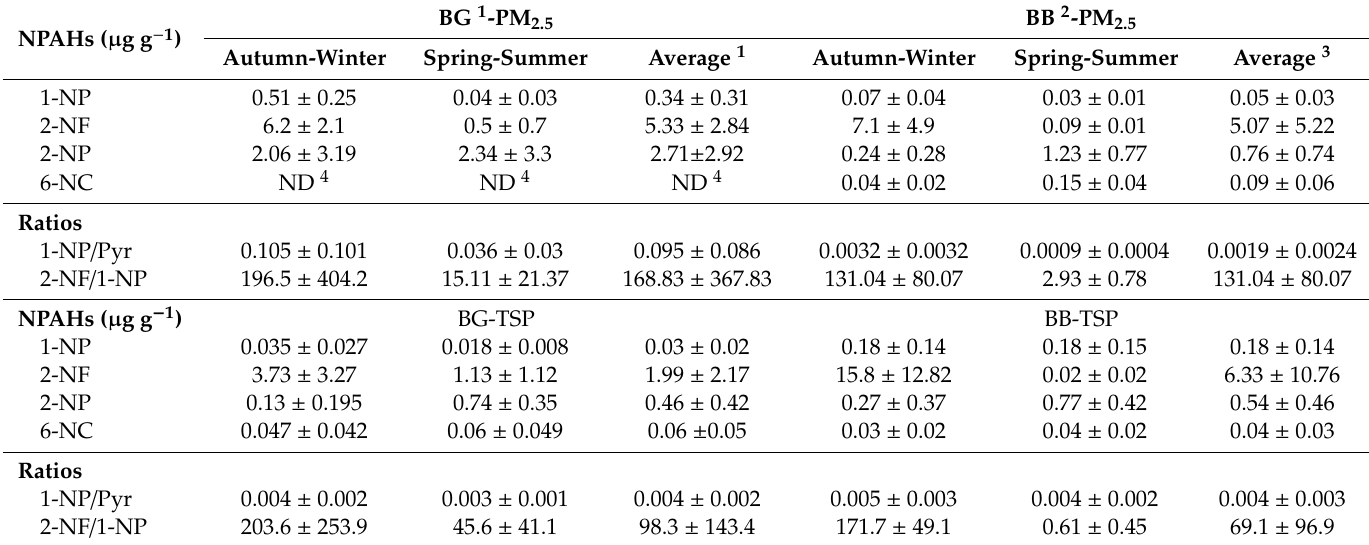
Table 4. NPAH concentrations and the NPAHs / PAHs ratios in PM 2.5 and